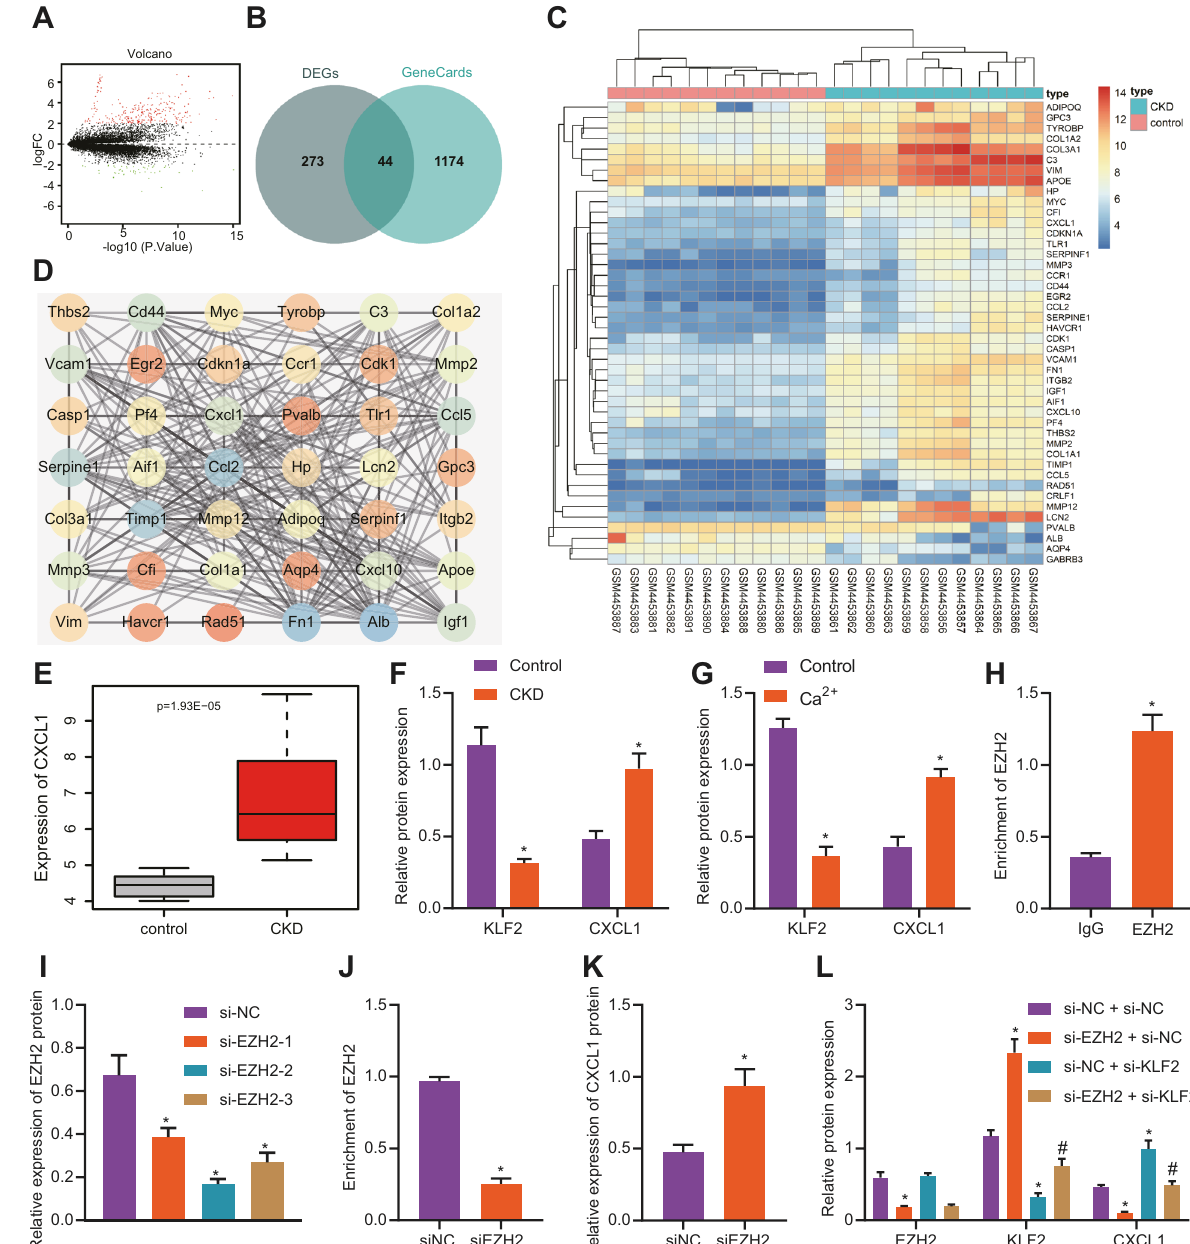
Fig. 4 EZH2 promotes CXCL1 expression in primary neurons by inhibiting KLF2. A The differential expression in CKD model mice related dataset GSE148084 gene was analyzed by volcano map, and the abscissa showed − log10 ( p Value), vertical coordinate represents log2FoldChange, the red dot indicates highly expressed gene, and green dot indicates poorly expressed gene. B Venn diagram of intersection of differential expression gene in CKD and nerve injury-related gene. C Differential expression heat map of a candidate gene in CKD dataset. The color scale from blue to red indicates expression value from small to large. D Gene interaction network diagram. The circle color scale from orange to blue indicates gene degree from low to high. E Expression of CXCL1 in CKD mice with GSE148084. F, The expression of KLF2 and CXCL1 in brain tissue of CKD mice was detected by Western blot analysis ( n = 8). * p < 0.05. vs. the control group (mice on a standard diet). G Western blot was analysis used to detect the expression of KLF2 and CXCL1 in the neurons induced by hypercalcemia. * p < 0.05. vs. the control group (neurons cultured in basic medium). H The binding of EZH2 and KLF2 promoter was detected by ChIP assay. * p < 0.05. vs . IgG. I Western blot analysis on EZH2 interference sequence. * p < 0.05. vs . the si-NC group (neurons treated with si-NC). J ChIP detecting EZH2 concentration in the KLF2 promoter region. * p < 0.05. vs. the si-NC group (neurons treated with si-NC). K KLF2 protein expression was detected by Western blot analysis. * p < 0.05. vs. the si-NC group (neurons treated with si-NC). L Western blot analysis was used to detect the protein expression of CXCL1 after EZH2 and KLF2 silencing simultaneously. * p < 0.05. vs. the si-NC group (neurons treated with si-NC). # p < 0.05. vs. the si-EZH2 + si-NC group (neurons treated with si-EZH2 + si - NC). The experiment was repeated 3 times independently.